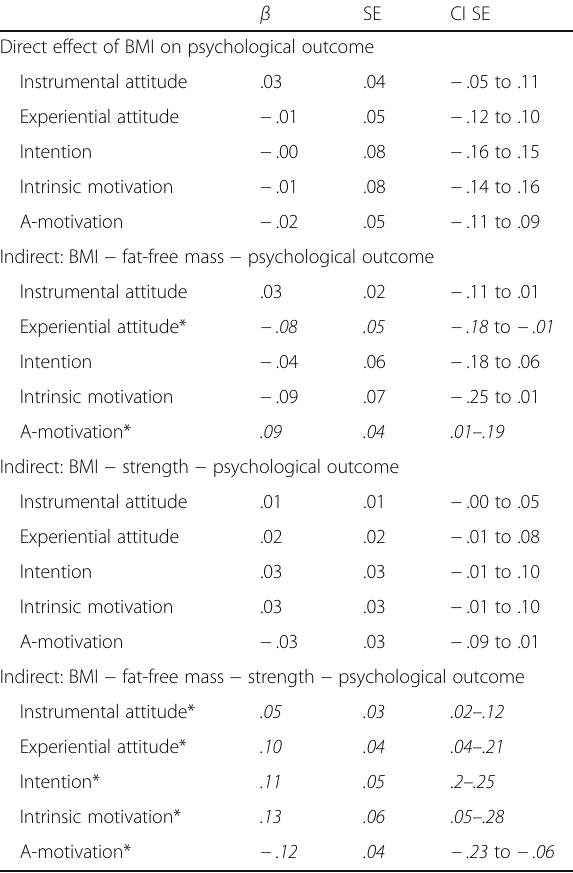
Table 4 Outcomes of the mediation analyses ( n =